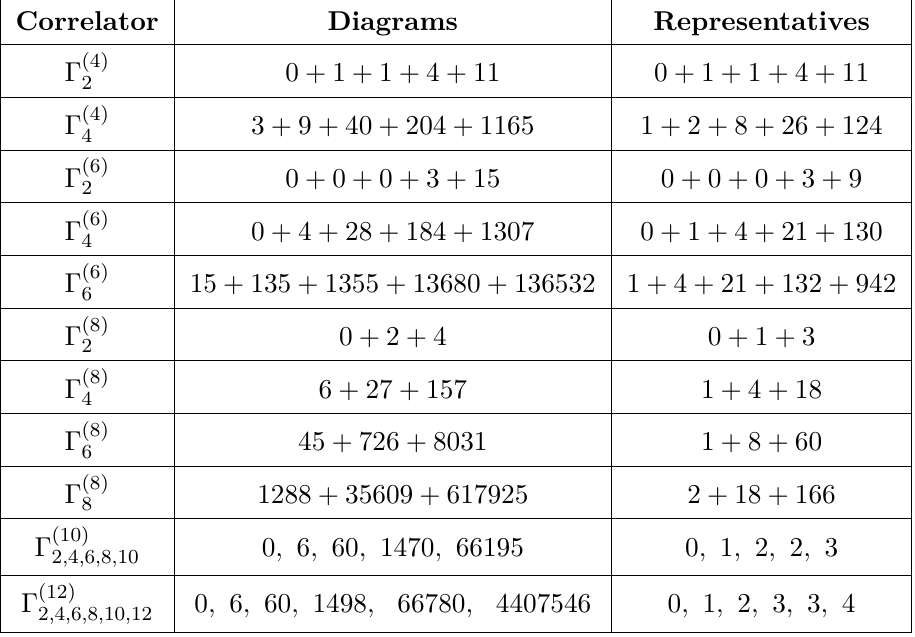
Table 1 . The number of calculated 1PI diagrams for the real scalar in a natural basis, where the ‘ + ’ explicitly show the contributions of each considered loop order. Γ ( n ) with N external legs at mass dimension n . When there exist multiple independent operators with the same field content, these are accounted for by a single